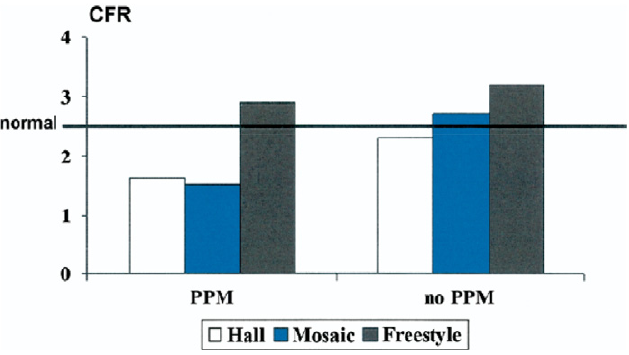
Figure.4 Reducedcoronaryflowreserve(CFR)inpatientswithprosthesis-patientmismatch(PPM)forMedtronic Hall Tilting Disc, Mosaic Stented, and Freestyle Stentless Valves. There were few patients with PPM in the stentless valve group and the results of CFR remained within normal ranges in this group. (Reproduced and modified with permission from